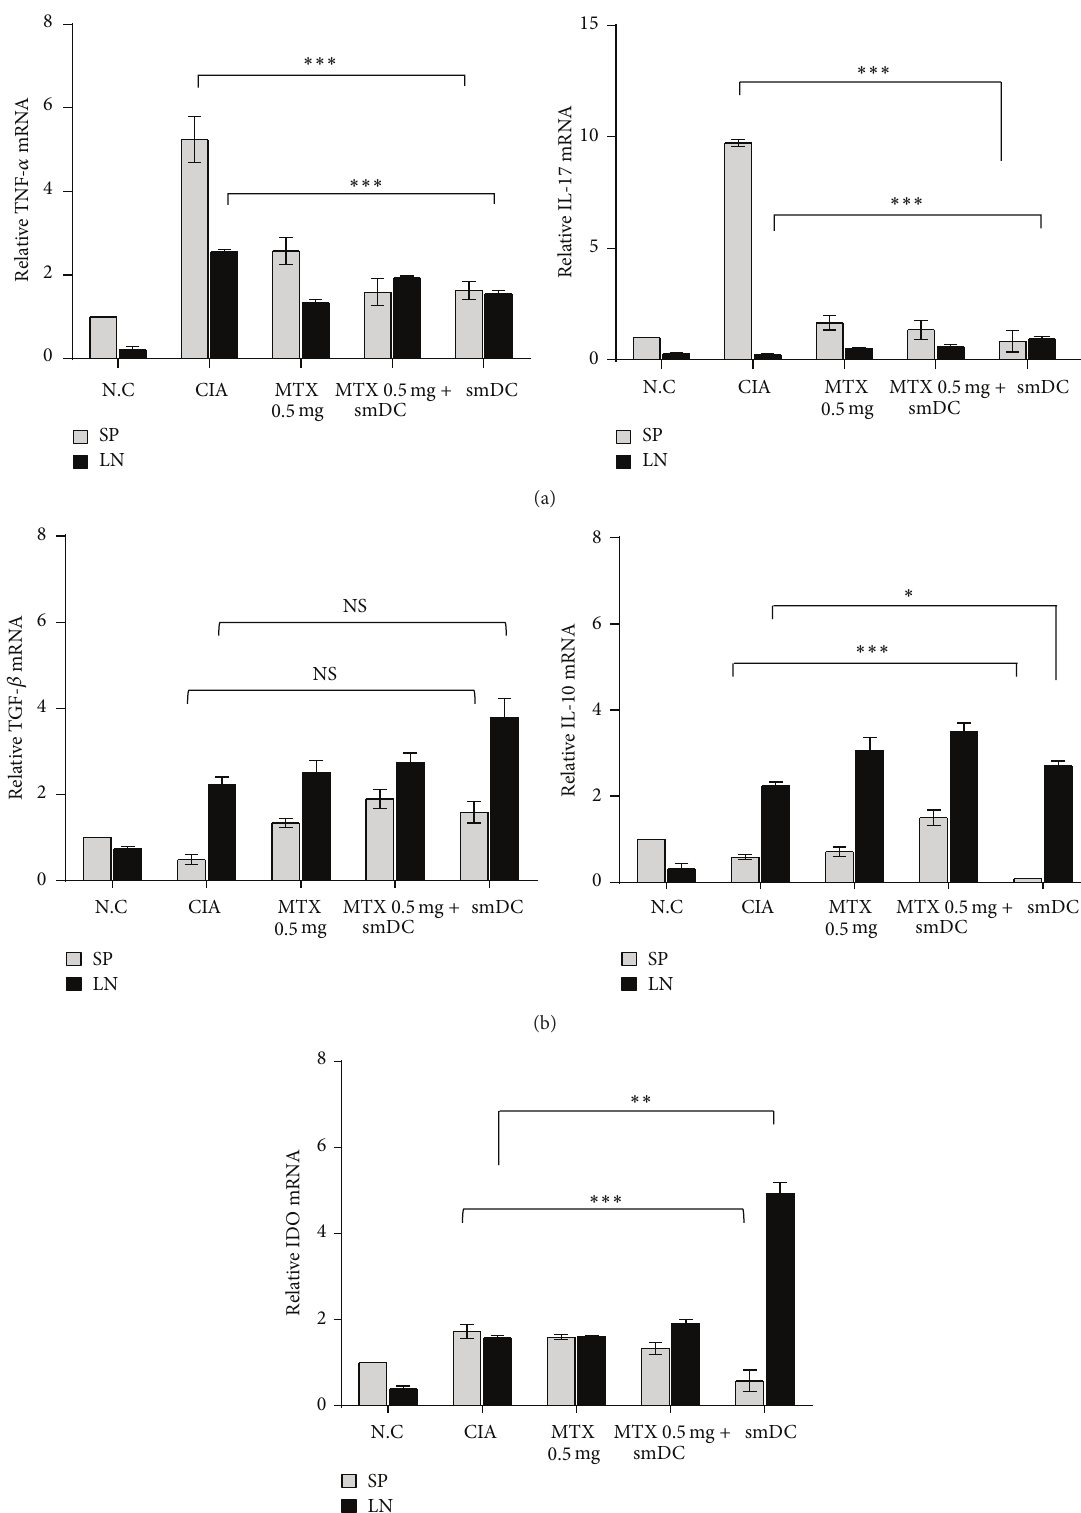
Figure 5: Treatment with smDCs or in combination with MTX made the secondary lymphoid organs of CIA mice become anti-inflammatory circumstances. Advanced CIA mice were treated with smDCs, MTX, or smDCs and MTX. Spleens and LNs were obtained from the treated mice on day 77 after first CII injection and total RNA was extracted from the organs. The mRNA levels of proinflammatory cytokines (a), anti- inflammatory cytokines (b), and immune-suppressive indoleamine 2,3 dioxygenase (IDO) (c) were analyzed by qRT-PCT using the ΔΔ CT method and are expressed as a percent of control. Statistical data are shown from more than 3 different sets of experiments as mean ± SEM. ∗ 𝑝 < 0.05 , ∗∗ 𝑝 < 0.001 , ∗∗∗ 𝑝 < 0.0001 in Student’s 𝑡